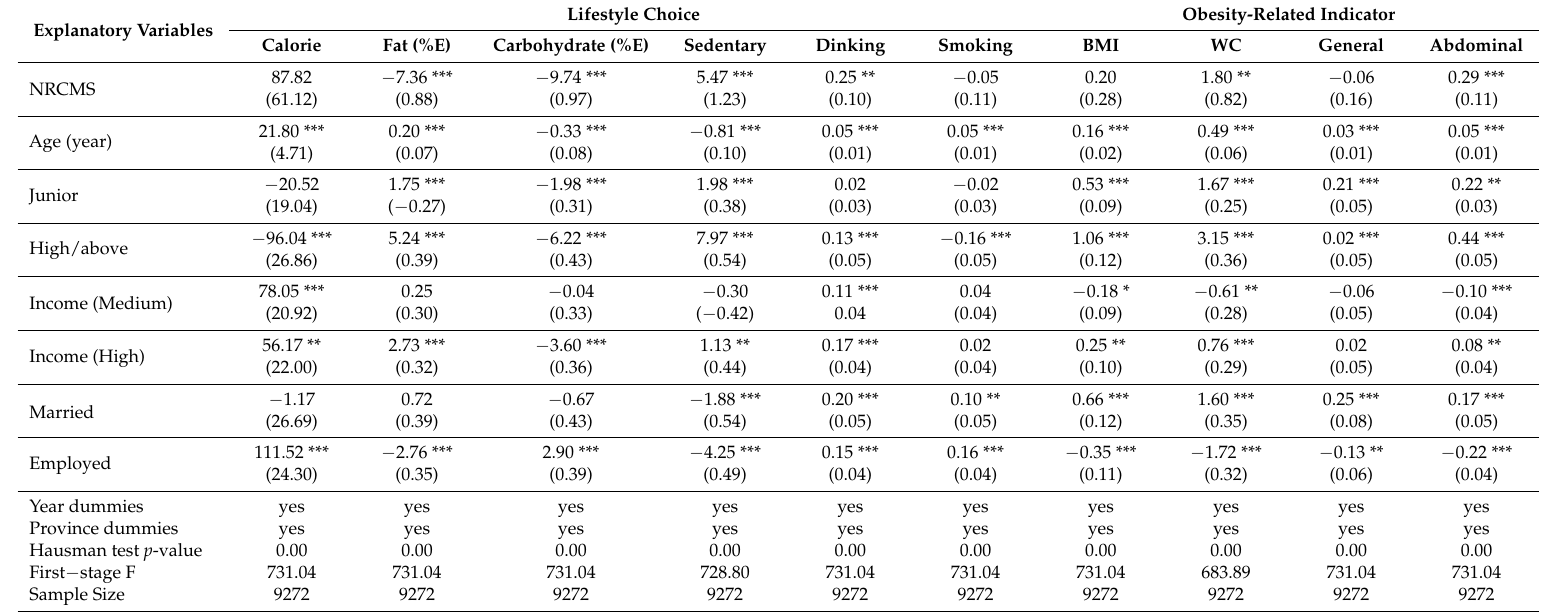
Table A4. Effects of the NRCMS on a male's lifestyle behavior choice and being